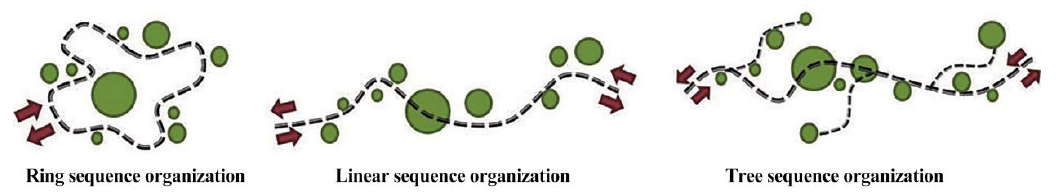
Fig. 3 Schematic diagram of the organisation of the landscape sequence.